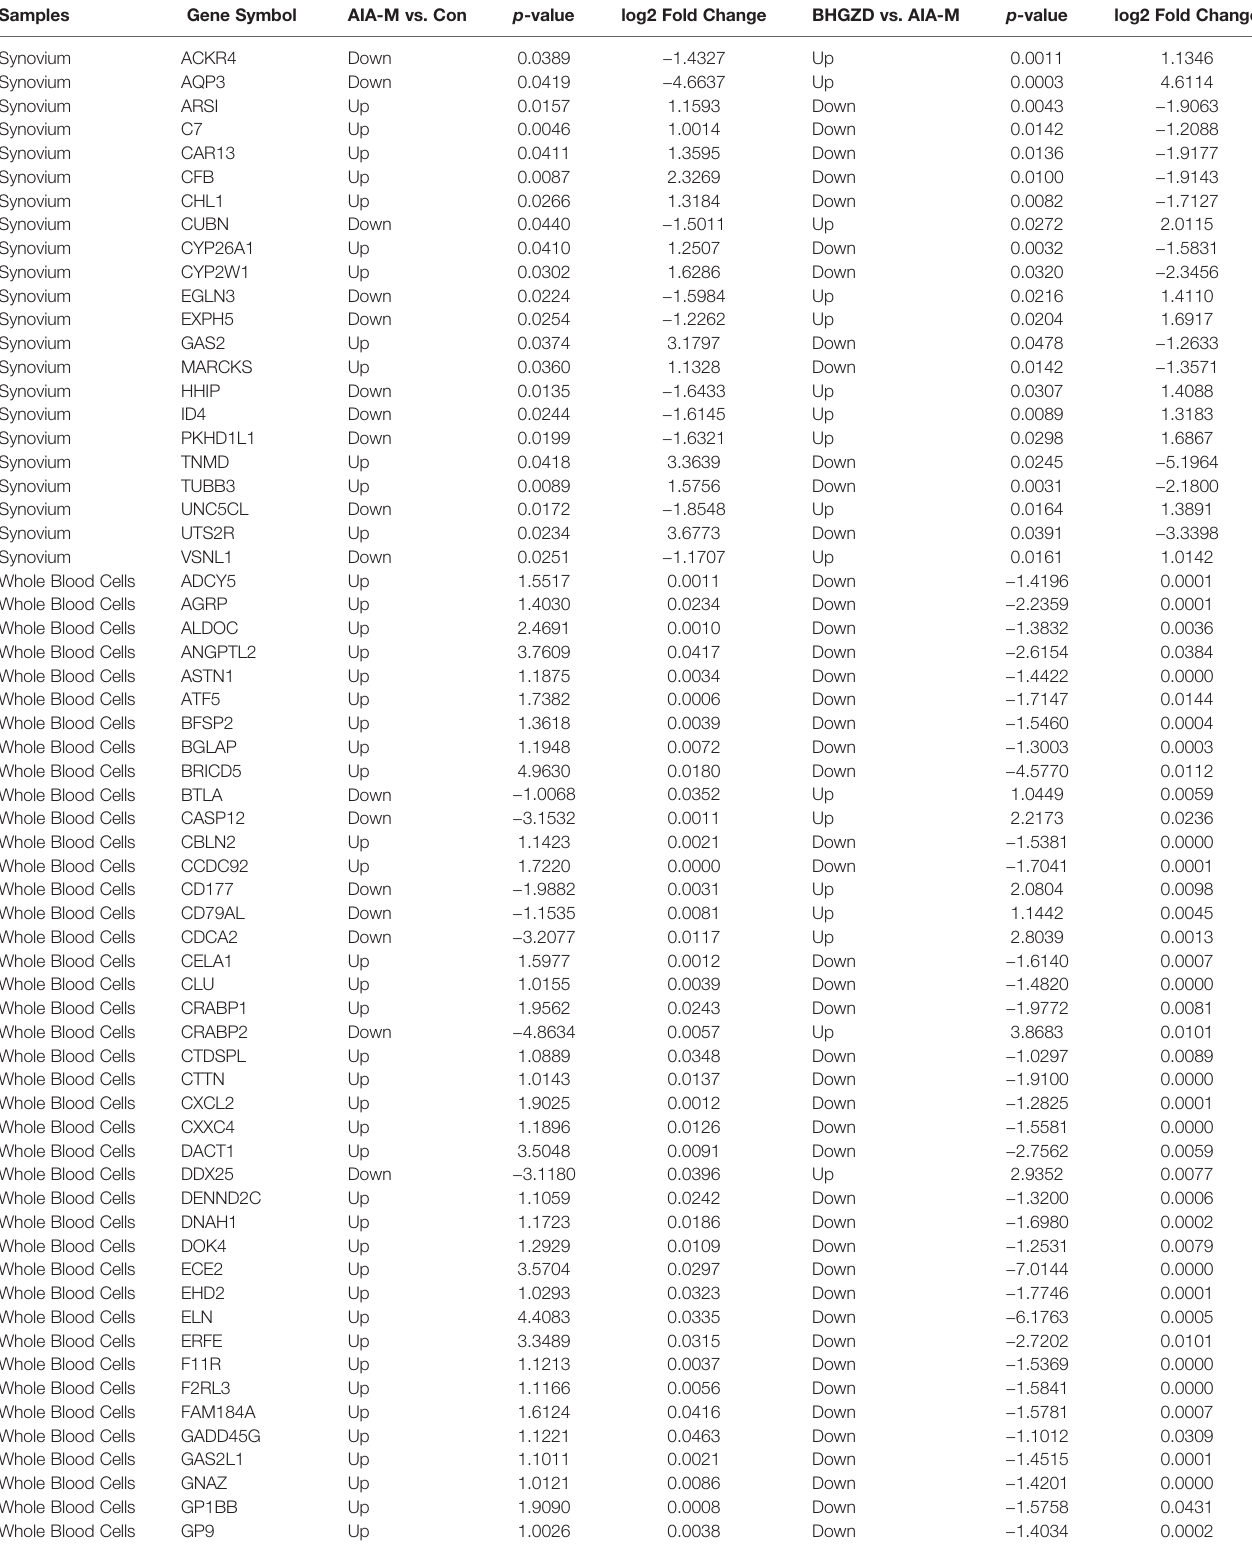
TABLE 1 | The information on 135 RA-related genes reversely regulated by the treatment of Baihu-Guizhi decoction (BHGZD).